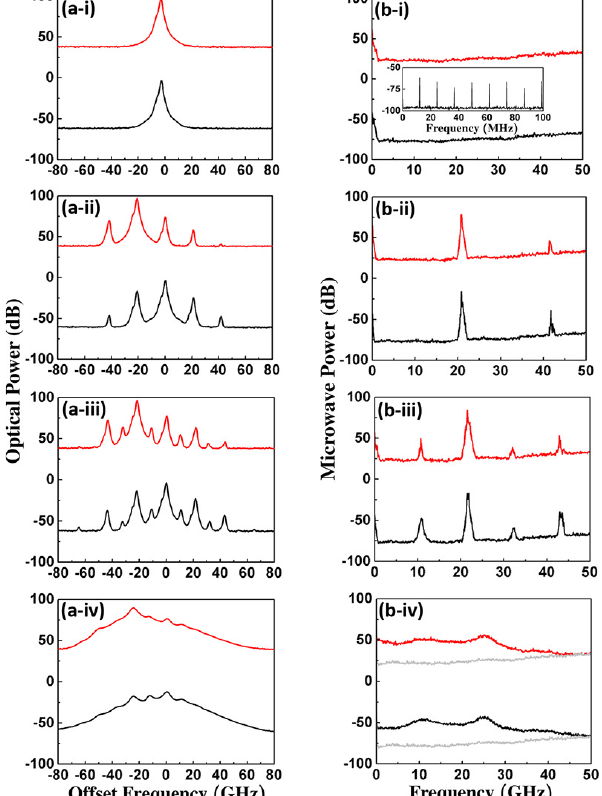
Figure 7. ( a ) Optical spectra and ( b ) microwave spectra of LD1 (red curve) and LD2 (black curve) for ( i ) mutual injection locking at ( ξ e , f i ) = (0.06, − 5 GHz), ( ii ) P1 dynamics at ( ξ e , f i ) = (0.1, − 20 GHz), 12 12 ( iii ) P2 dynamics at ( ξ e , f i ) = (0.15, − 20 GHz), and ( iv ) chaos at ( ξ e , f i ) = (0.28, − 20 GHz). The inset 12 12 of ( b-i ) shows the enlargement of the microwave spectrum for LD2 around 0 GHz. The x -axes in ( a ) are relative to the free-running oscillation frequency of LD2. The red curves in ( a , b ) are up-shifted by 100 dB for clear visibility. The gray curves in ( b-iv ) show the noise floor of the laser